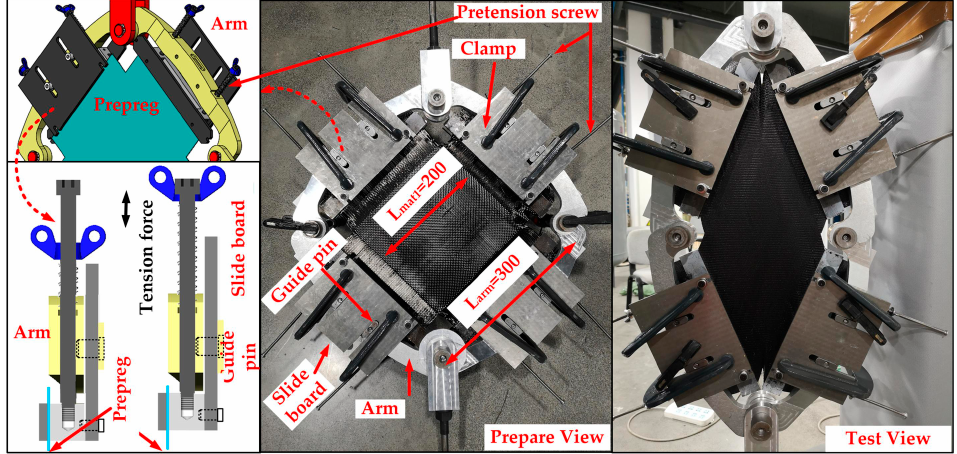
Figure 6. Picture of the PF test device.